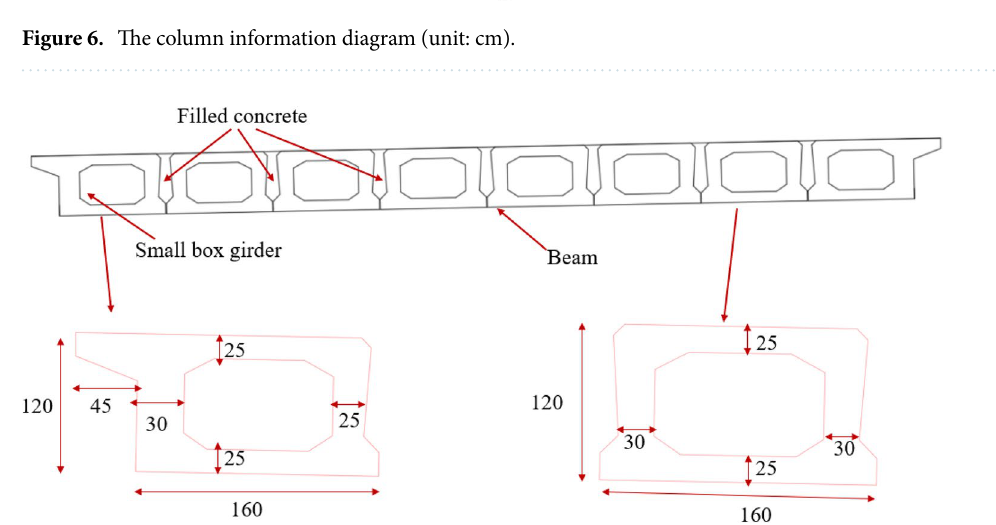
Figure 7. The main beam (unit: